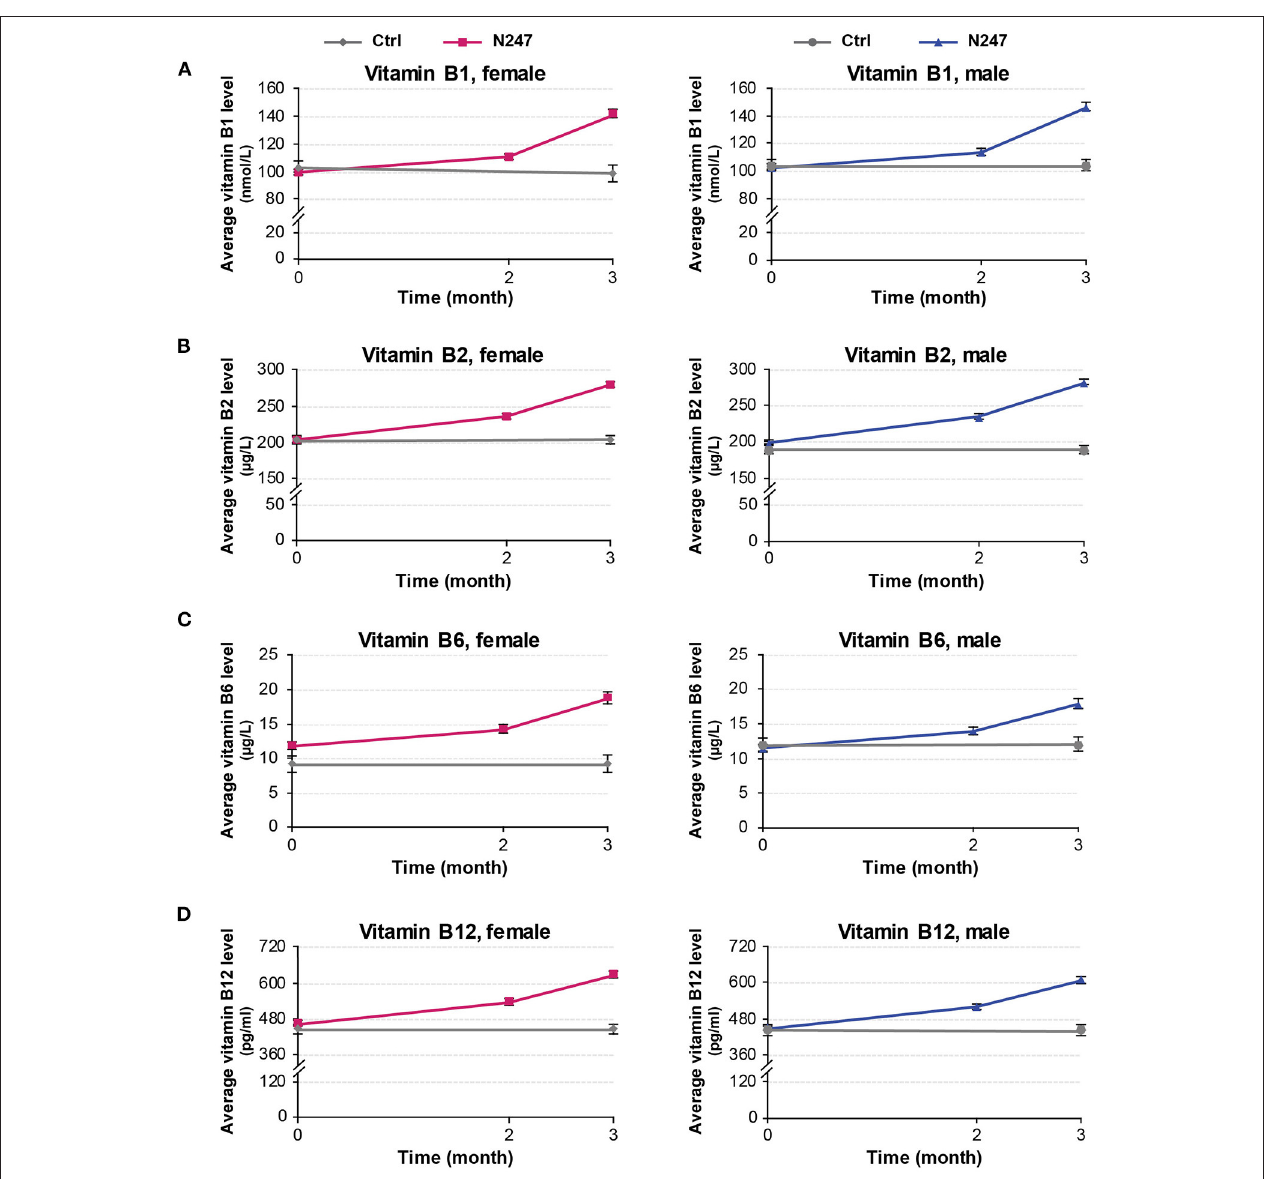
FIGURE 4 | Graphical representation of N247 effects on serum vitamin B1, B2, B6, and B12 levels. Serum concentrations of vitamin B1 (A) , vitamin B2 (B) , vitamin B6 (C) , and vitamin B12 (D) in control and N247 receiving group of women and men subjects during the study. Values are mean